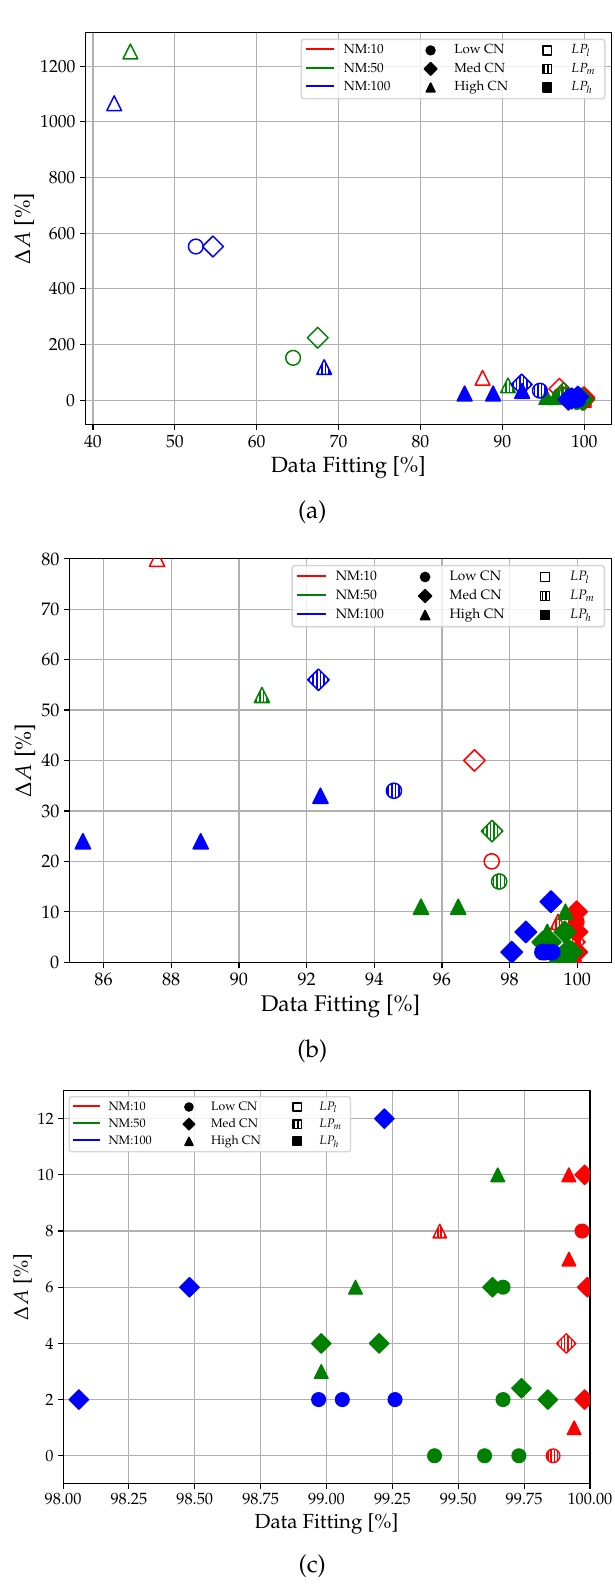
Figure 18. Correlation between the data fitting and the ∆ A scatter: the data are related to NM, CN, and LP. Different zoom levels of data fitting are proposed in order to highlight different details: (a)